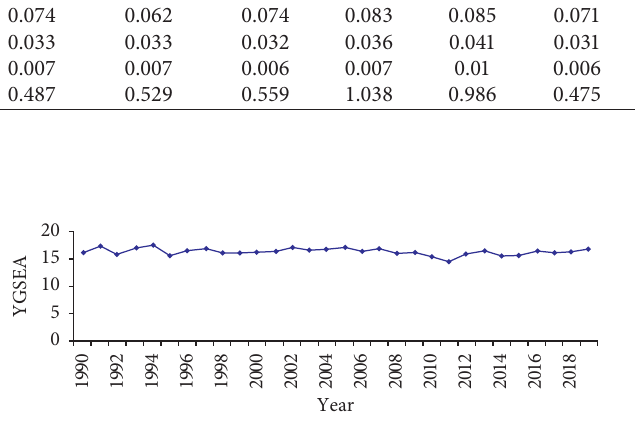
Figure 2: Yearly global solar energy average in Queensland, Australia.